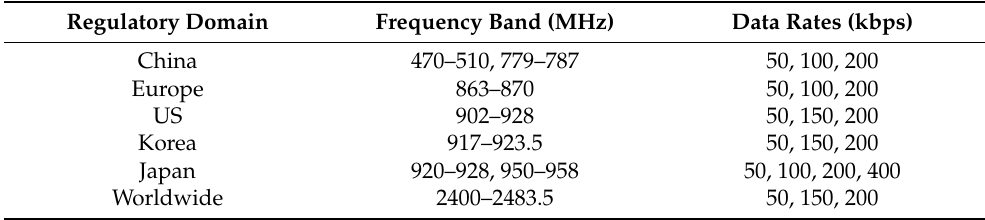
Table 2. Data rates and frequency bands of MR-FSK PHY layer in different